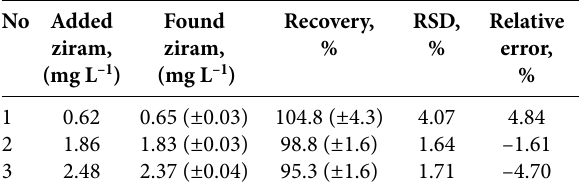
Table 4. Recovery values obtained by standard addition method in peach juice using RGO/AuNPs/GCE sensor. No Added